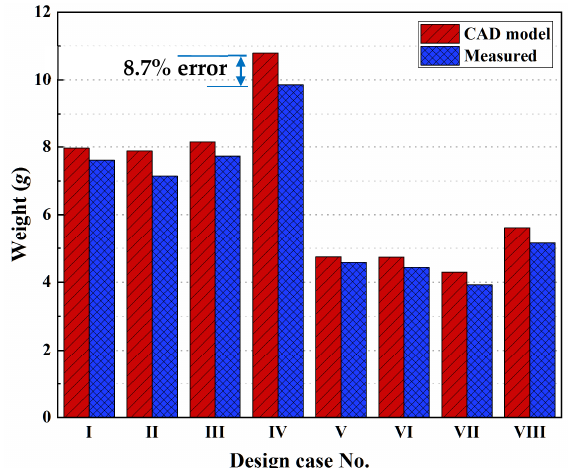
Figure 8. The weight of the eight types of lattice samples compared to their CAD models.